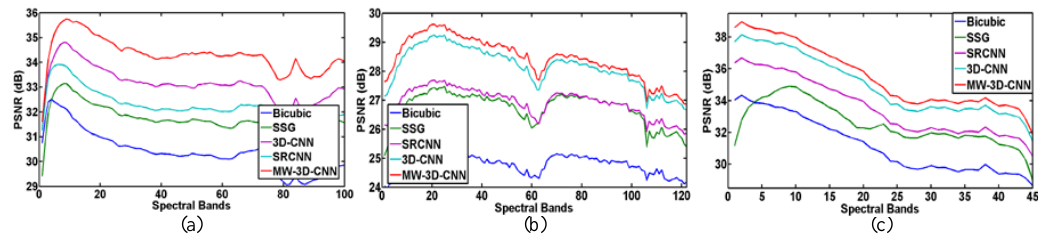
Figure 5. Peak-signal-noise-ratio (PSNR) indices of each bands of di ff erent hyperspectral image super-resolution (HSI SR) methods by an upscaling factor of two, ( a ) on Pavia University , ( b ) on Chikusei ( c ) on Houston University (grss_dfc_2018). Table 1. The assessment indices of di ff erent HSI SR methods by an upscaling factor of two.